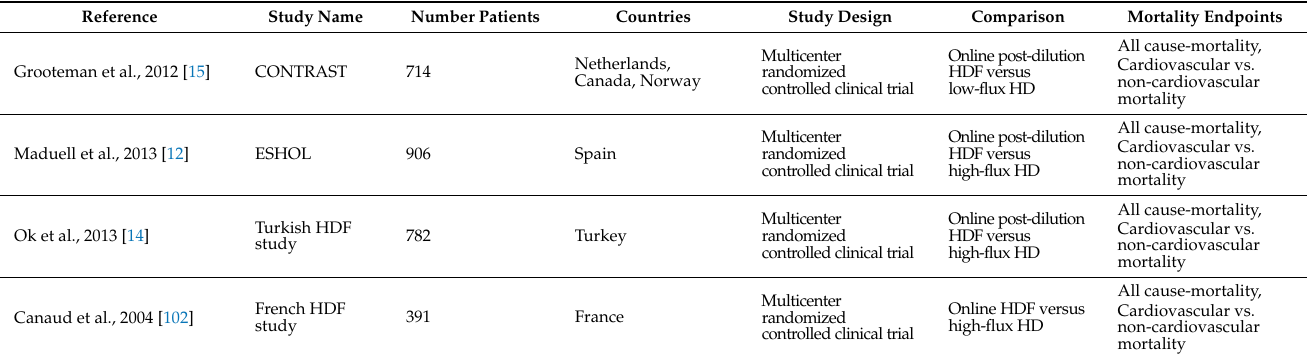
Table 1. European pooling data meta-analysis study [13].